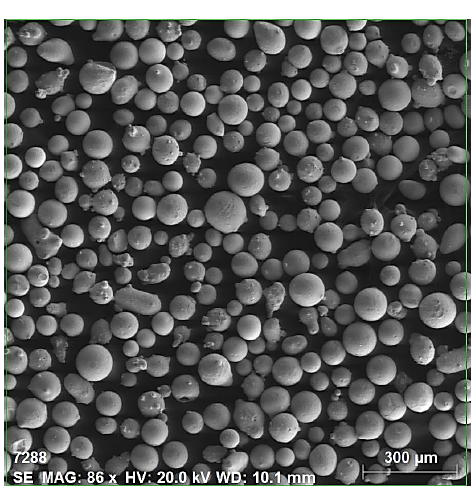
Figure 1. SEM micrographs of the 40NiCrBSi + 60WC blended powder.